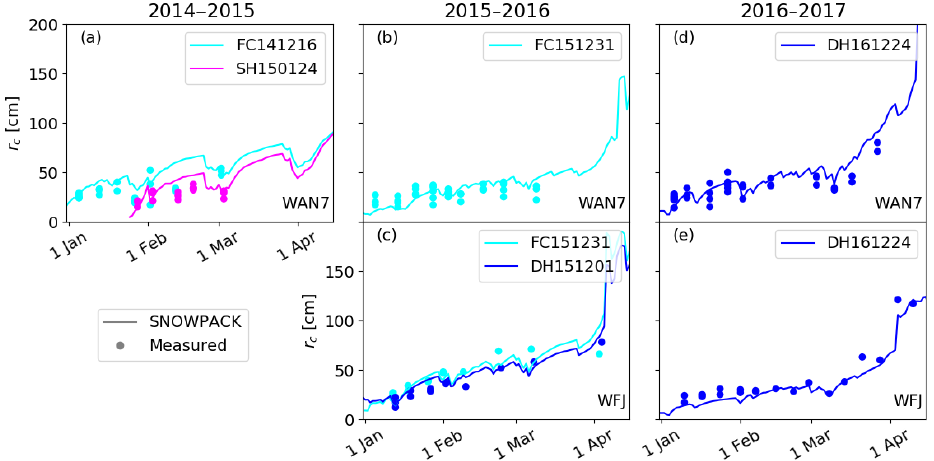
Figure 11. Evolution of the critical crack length at WAN7 (a, b, d) and WFJ (c, e) for the winter seasons 2014–2015 ( a WAN7), 2015–2016 ( b WAN7; c WFJ), and 2016–2017 ( d WAN7; e WFJ). Dots represent mean measured r c values from PST experiments, and lines represent modeled r c values with layer properties from SNOWPACK using Eq. (8).